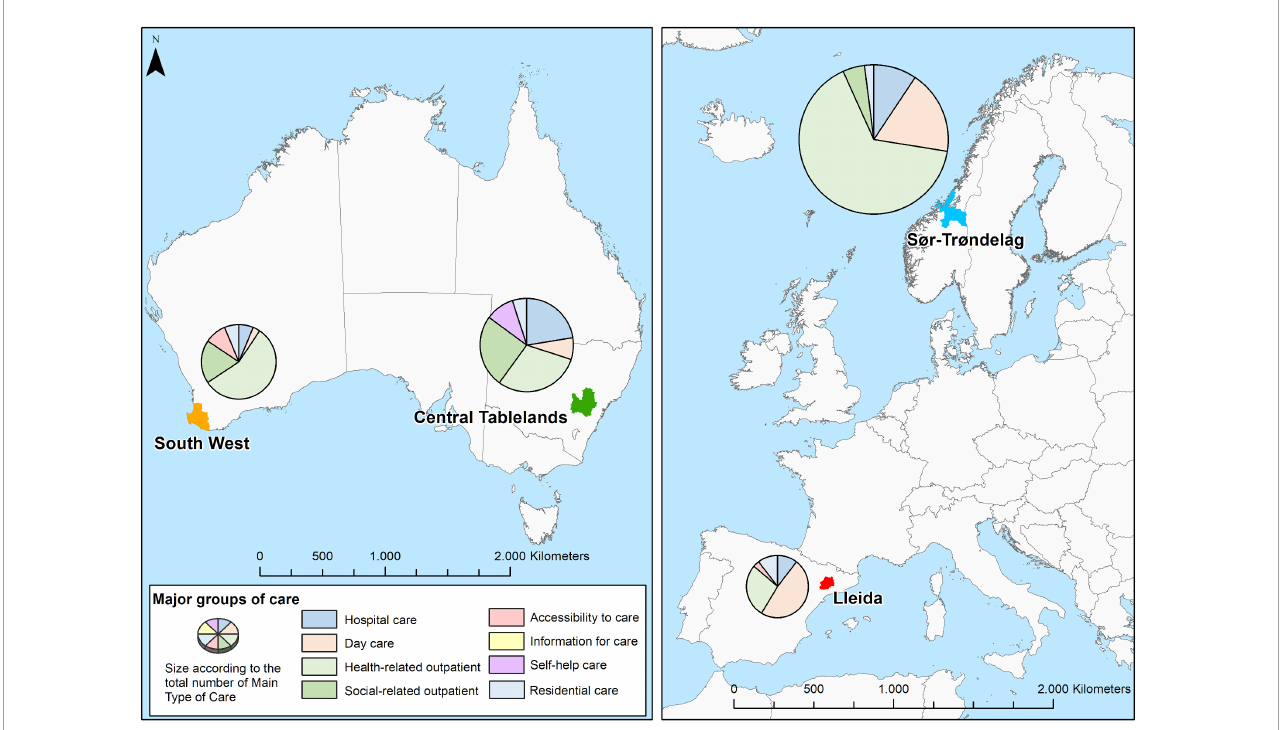
FIGURE1 Location of South West and Central Tablelands regions (Australia), Lleida (Spain), and Sør-Trøndelag (Norway), and proportions of mental health care by main branches of the DESDE-LTC system in the four areas.